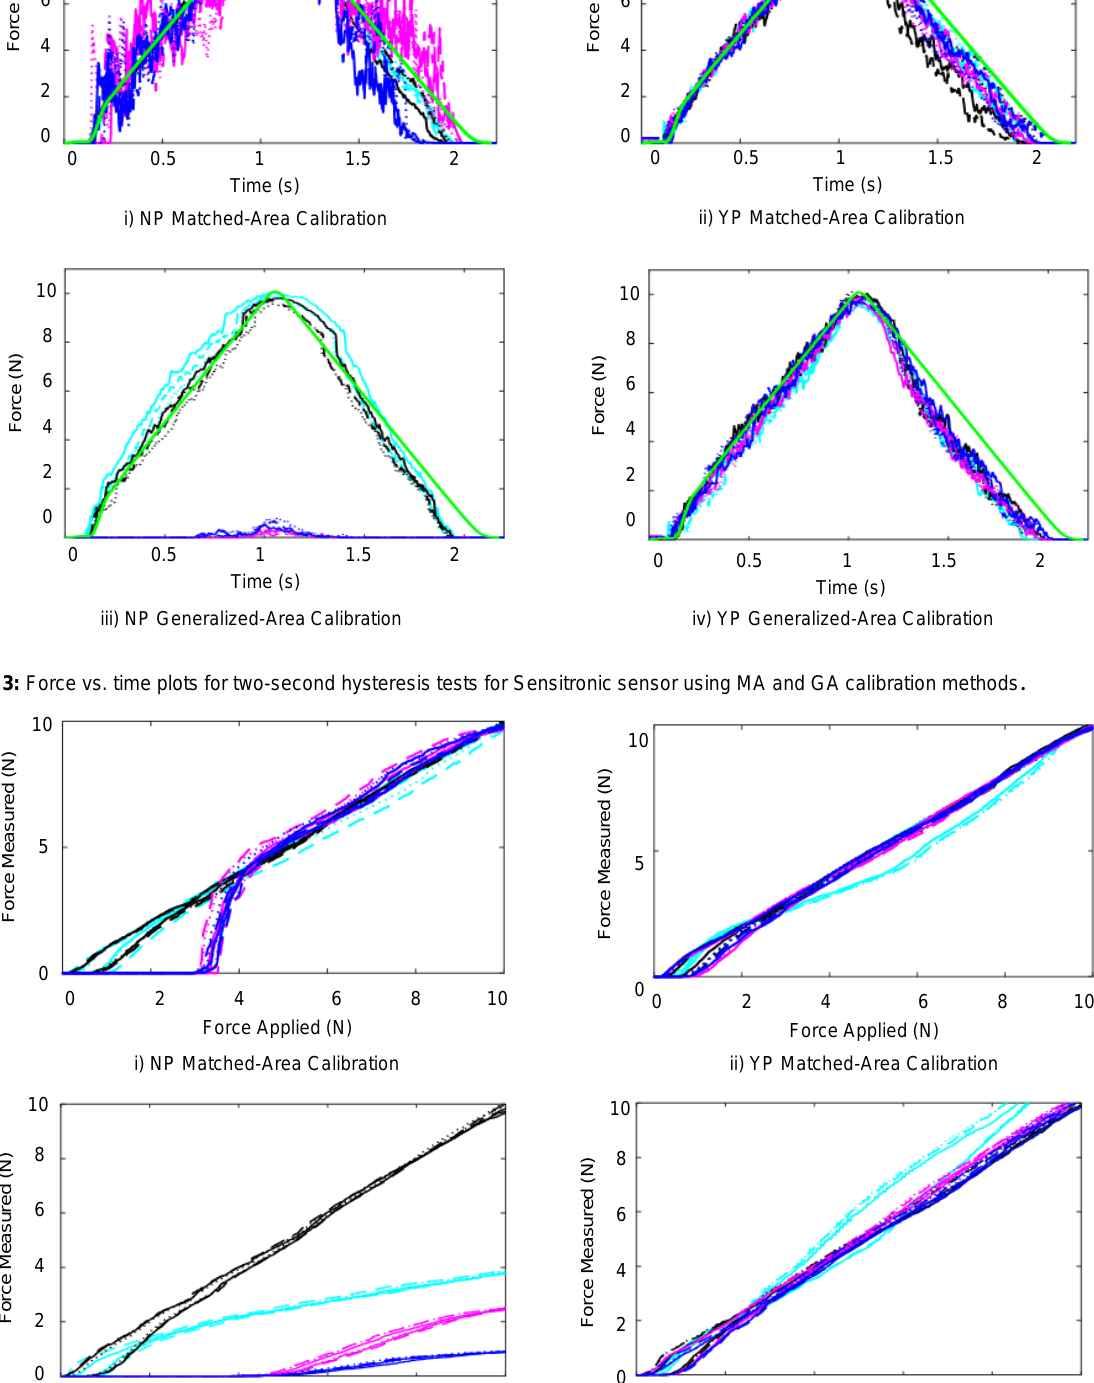
Figure 4: Force measured vs. force applied plots for two-second hysteresis tests for Peratech using MA and GA calibration